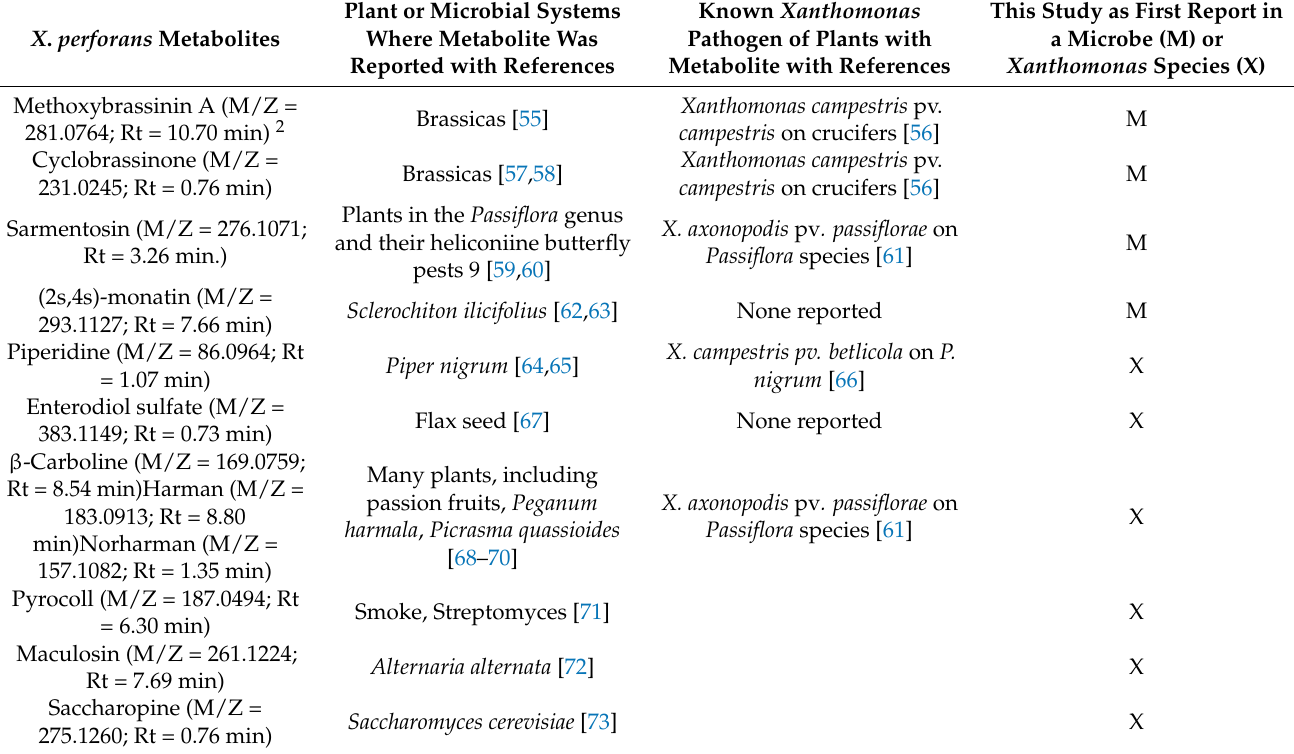
Table 2. Some metabolites of plants and other microbial systems of novel identification in the Xanthomonas perforans metabolome 1